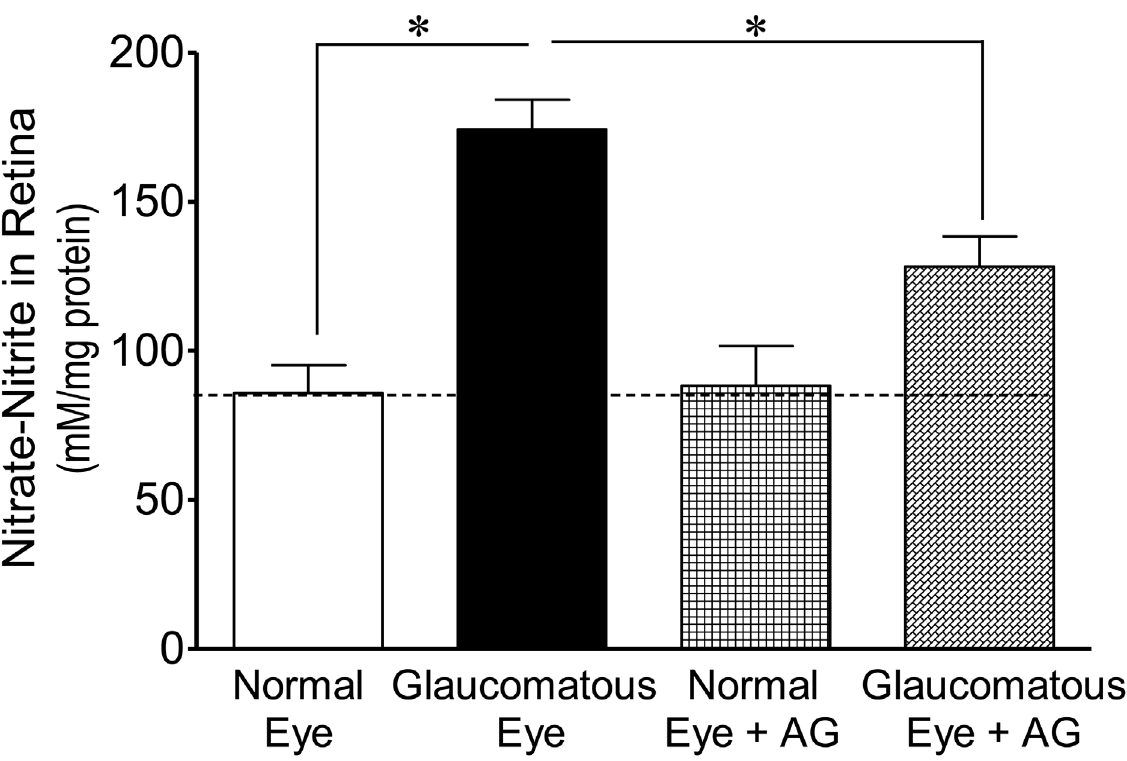
Figure 5. Measurements of nitrate-nitrite in normal and glaucomatous eyes in the presence of AG. Animals were treated with AG (25 mg/kg, i.p.) 30 minutes after glaucomatous injury and continued for 7 days, once daily. The absorbance was measured at 550 nm and absorbance was plotted against the nitrate standards. The amount of nitrate-nitrite is expressed as millimolar nitrates-nitrites per milligram protein. Data are expressed as mean 6 SEM, (* P , 0.05;